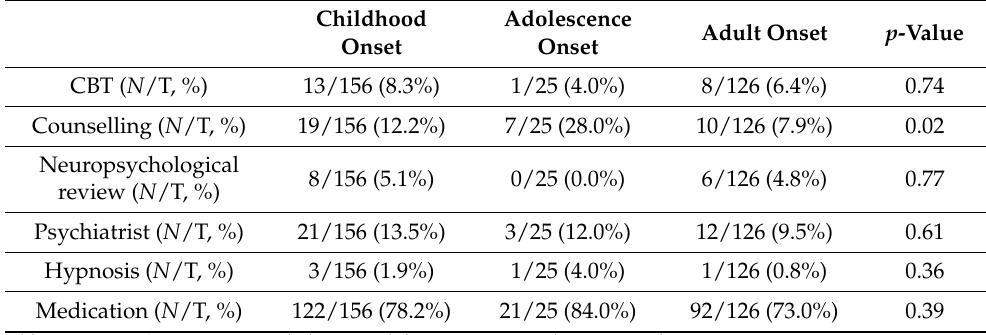
Table 7. Type of treatment for patients with NREM parasomnia split by age of onset ( p at 0.05/3 = 0.017).